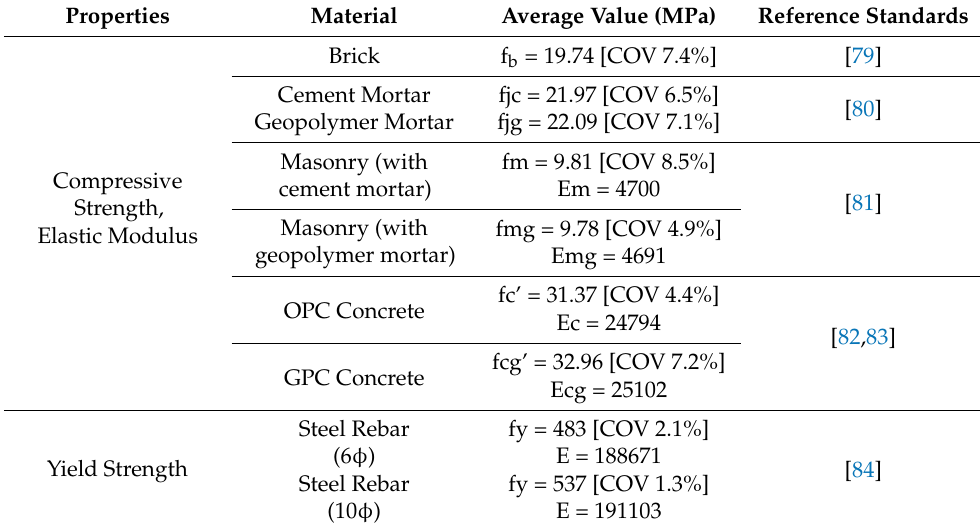
Table 1. Experimental material characteristics.